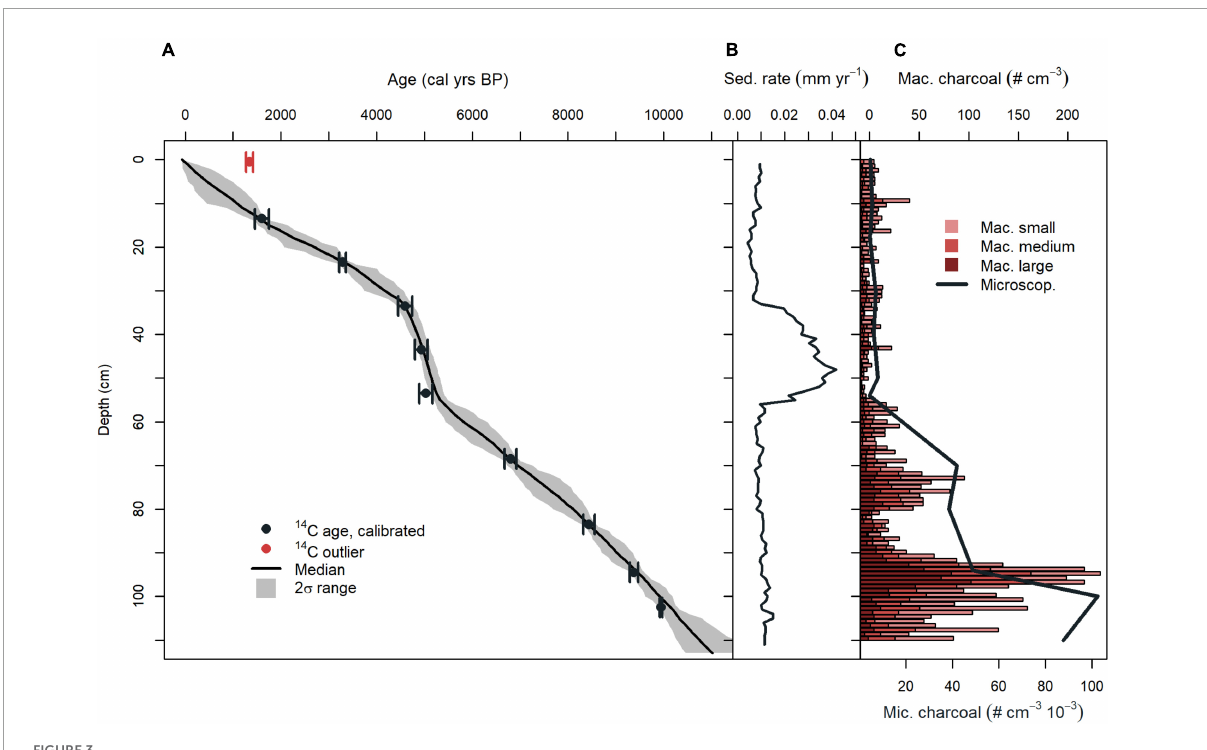
FIGURE3 (A) Bulk-sediment 14 C-based chronology for sediment core EN18224-4. (B) Sedimentation rate, as derived from the chronology. (C) Concentrations of macroscopic charcoal, divided by size classes (bars), and microscopic charcoal found in pollen samples